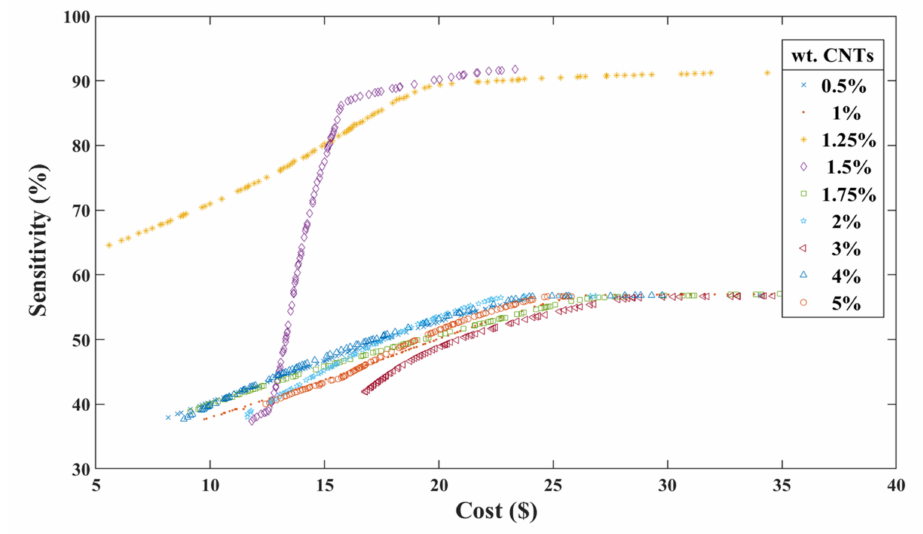
Figure 9. 2D Pareto Frontier of sensitivity and cost of active materials, for different CNTs